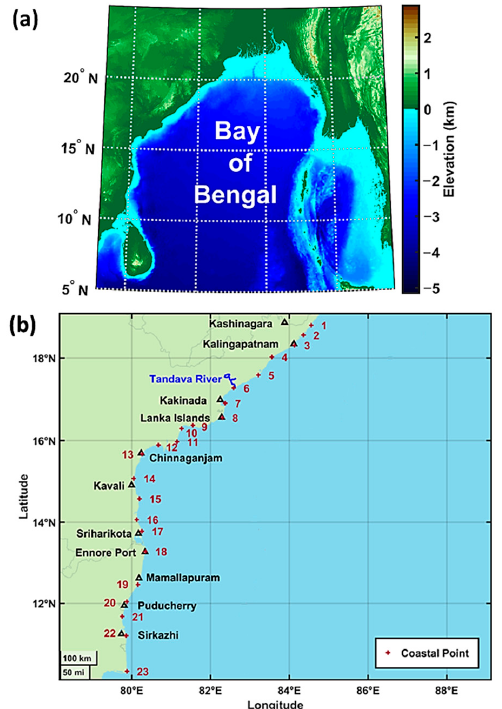
Figure 1. ( a ) Study area with overlaid bathymetry; ( b ) Coastal observation